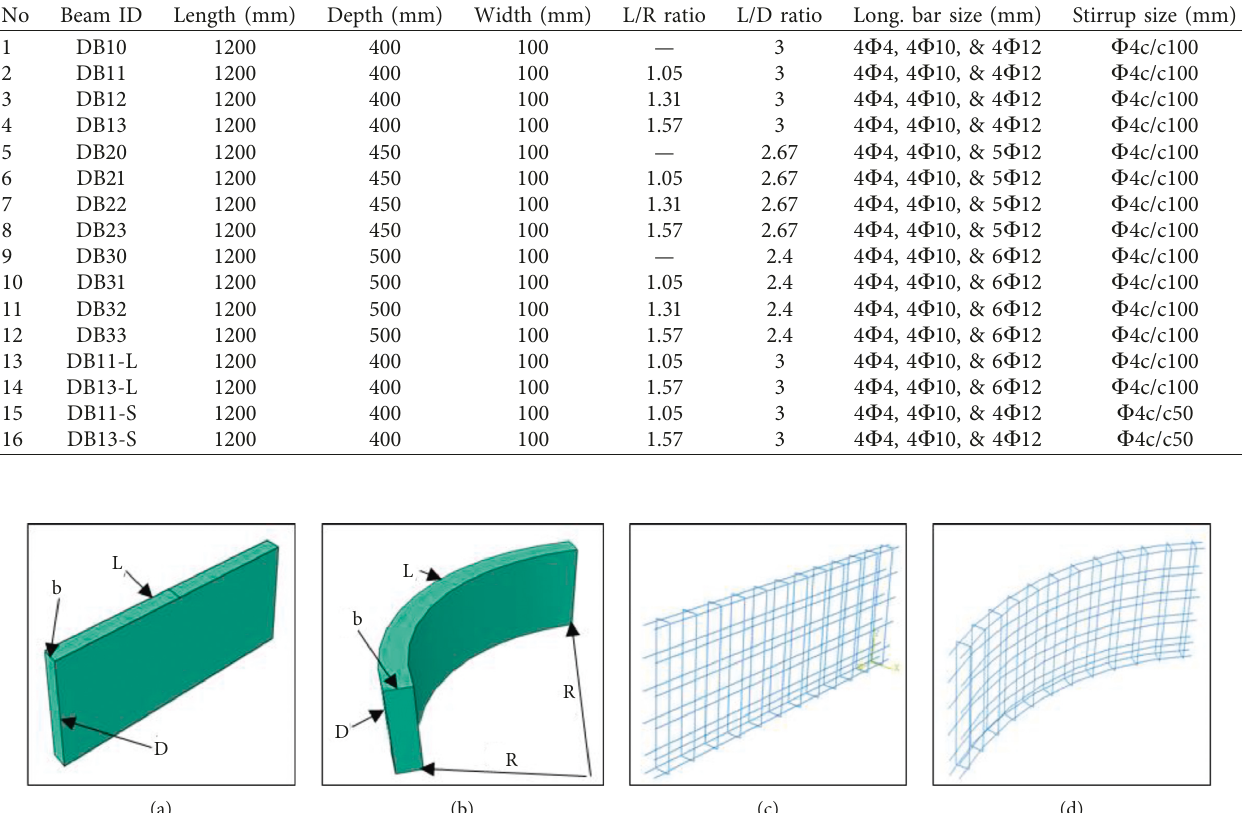
Table 4: The case understudied and the dimension of the deep beams model.